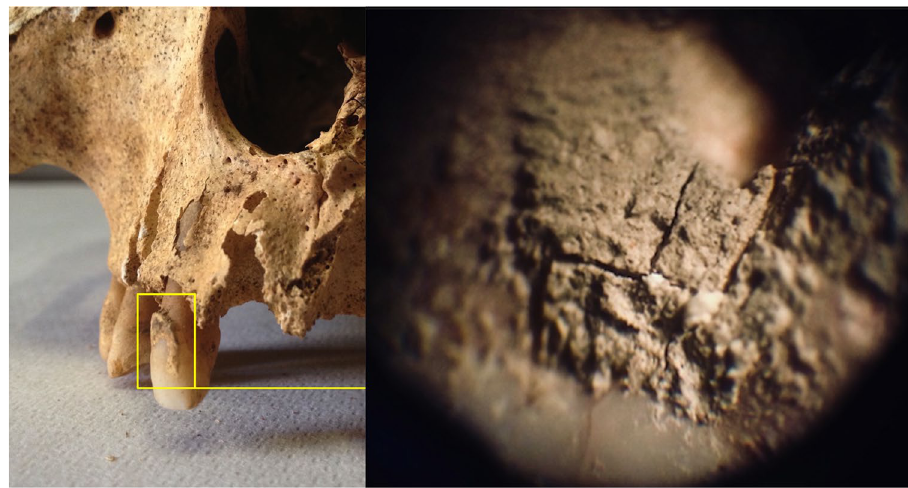
Figure 2. Dental calculus . Dental calculus in an ancient masculine maxillary left lateral incisor and its structure magnified under a light microscope